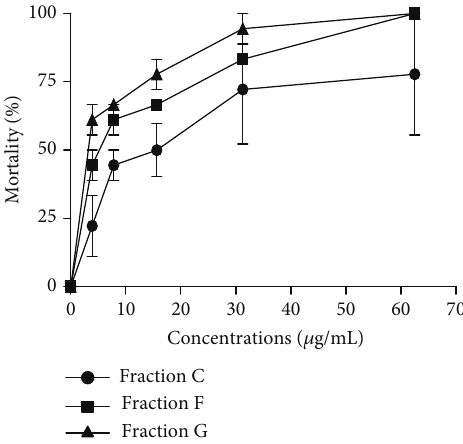
Figure 2: E ff ect of chromatographic fractions of Indigofera tinctoria on Onchocerca ochengi after 72 h of